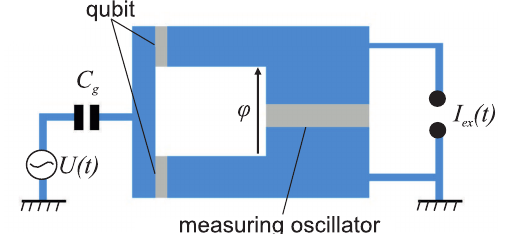
Figure 1. Sketch of a quantronium qubit coupled to a measuring oscillator. The measuring oscillator is a Josephson junction with Josephson energy E R